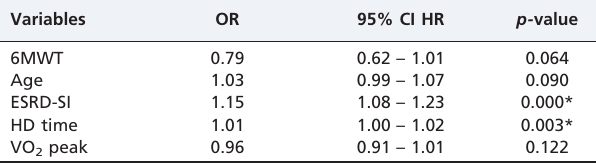
Table 3 - Cox multivariate analysis stratified by 100-meter